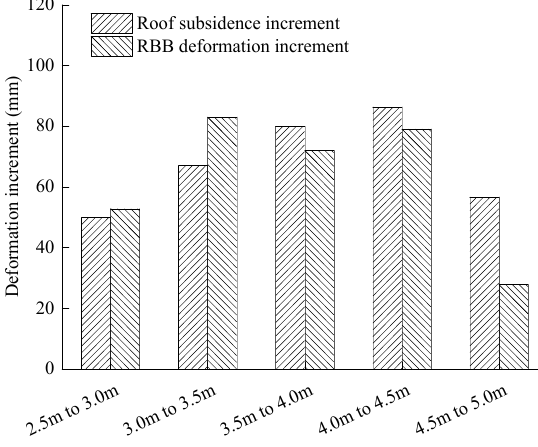
Figure 9. Increment of surrounding rock deformation for GER.